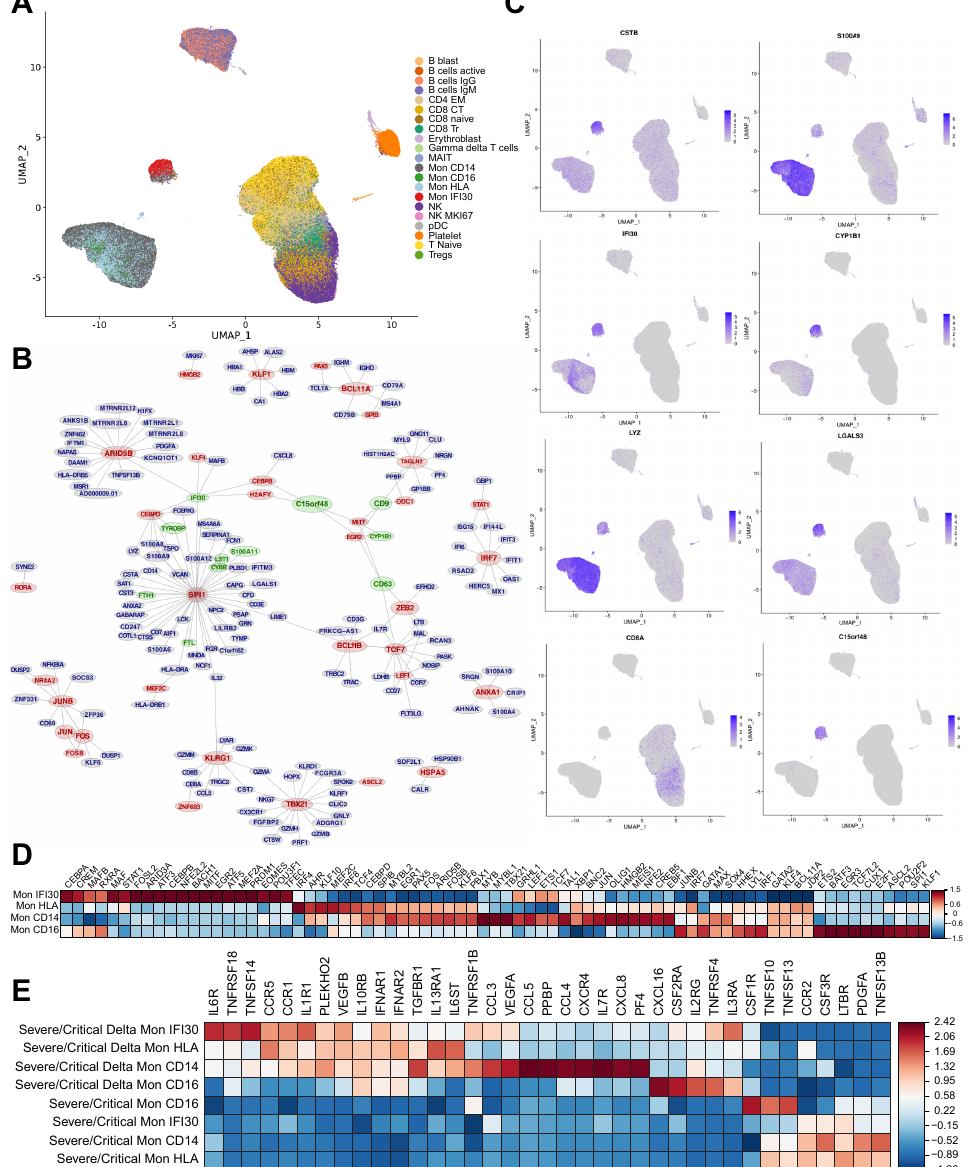
Figure 4. ( A ) UMAP with colored cell annotation as obtained based on the CCA integration. Cell placing on the plot reflects similarities and colocalization of the cell types. ( B ) Fragment of the gene regulatory network reconstructed based on single − cell gene expression obtained for the whole dataset. Top 200 gene regulators (TFs) with their the most confident targets are plotted. Red color highlights important regulators that were recovered based on the SCENIC gene regulatory network reconstruction. Green labels show markers of the Mon IFI30 cell subtype. Network visualized using Fruchterman − Reingold layout algorithm. ( C ) Expression of the marker genes as projected on the SCENIC − based UMAP indicates activity of the core marker genes and colocalization of the cell subtypes. Mon IFI30 marker genes (LGALS3, CSTB, and C15orf48) are highly expressed in the population that was previously identified using CCA integration and clustering. ( D ) Heatmap with average gene expression for transcription factors that are differentially expressed (logFC > 0.75) in each cell type with respect to other monocytes. ( E ) Heatmap with average cytokine expression in monocytes for Delta and Wuhan − like